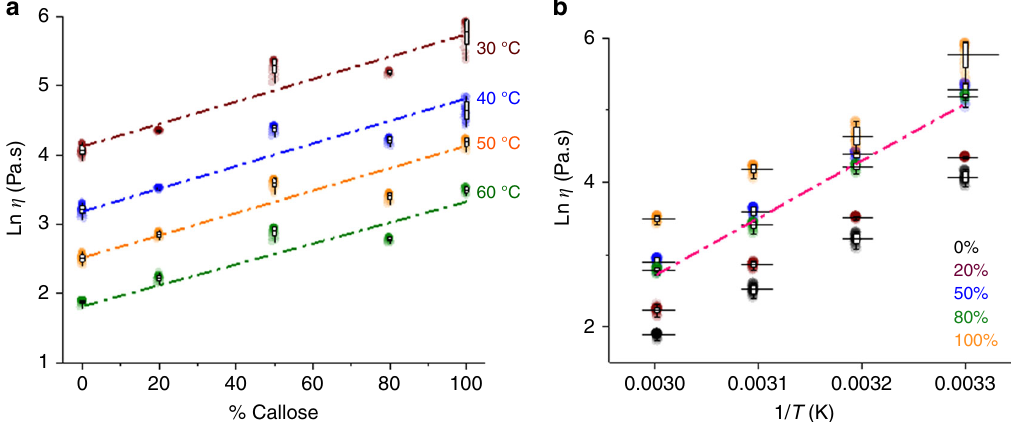
Fig. 5 Zero shear rate viscosity values as a function of callose concentration and temperature in the mixtures of ionic liquid solution. a shows the Ln of the viscosity ( η ) at the different callose percentage and within the temperature range 30-60 °C. A linear fi tting (mixing rule) is presented in discontinuous lines in brown for 30 °C, blue for 40 °C, orange for 50 °C and green for 60 °C. The graph in b shows changes in the viscosity values as a function of temperature at the different callose concentrations (%). The discontinuous pink line in b shows the theoretical values predicted for the 50% composition as calculated using the ideal mixing rule. Box plots represent the fi rst (25%) and third (75%) quartiles, the central horizontal line is the mean, and outliers at the 1% and 99% level are indicated by the whiskers. Individual data points for four- fi ve independent replicas are shown, with between 20 and 40 repeat measurements for each concentration/temperature combination. Every individual data point is plotted at 80%